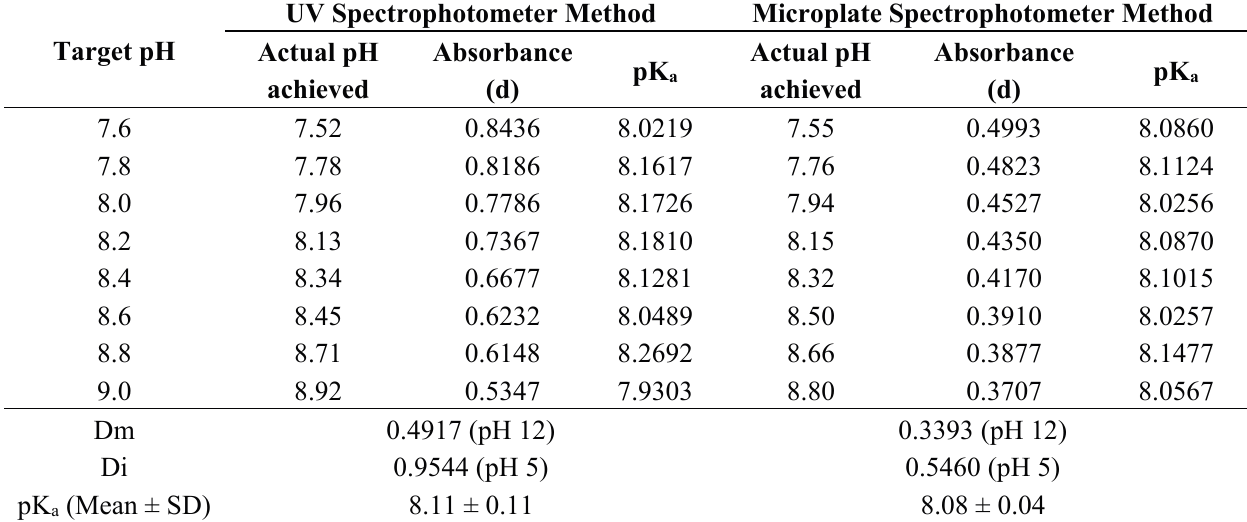
Table 1. Typical mitragynine absorbance at various pH and determination of pK a using the UV spectrophotometer and microplate spectrophotometer